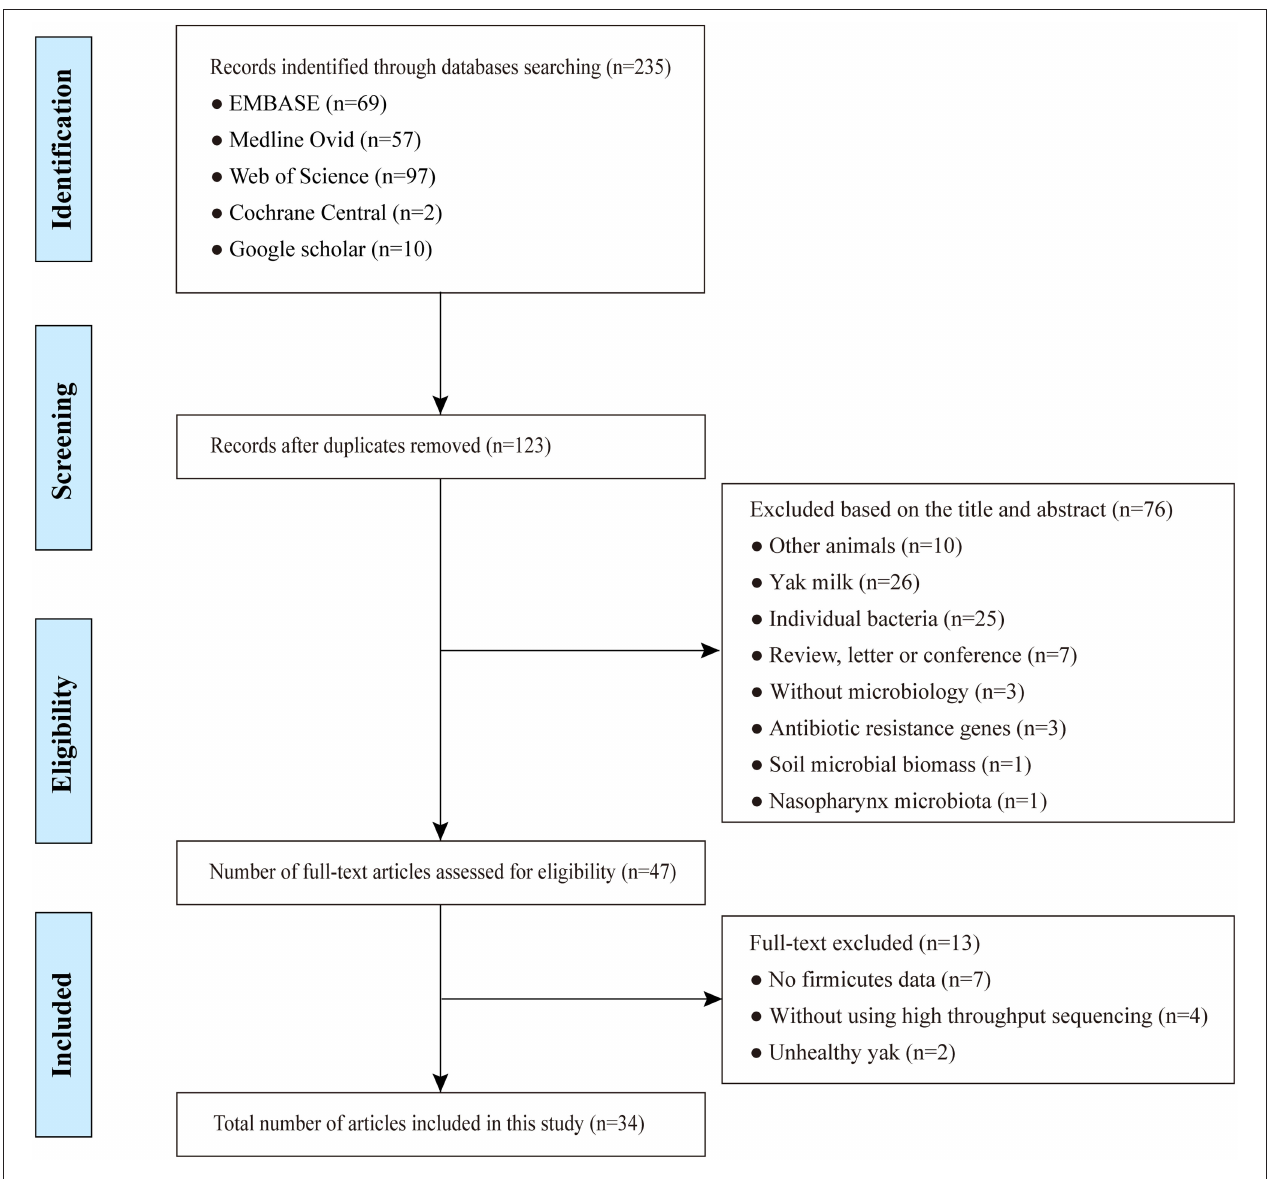
FIGURE 1 | Flowchart diagram of screening and selection